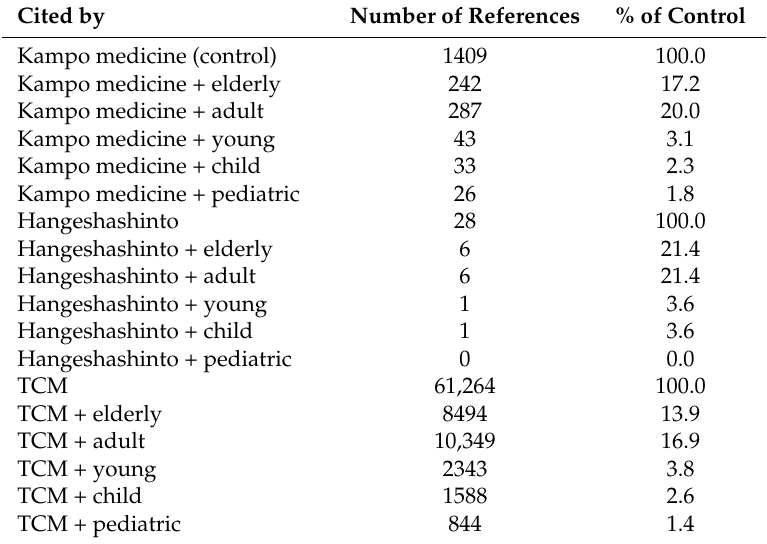
Table 4. Medicines used for treatment of stomatitis (data obtained from Pubmed on 16 January